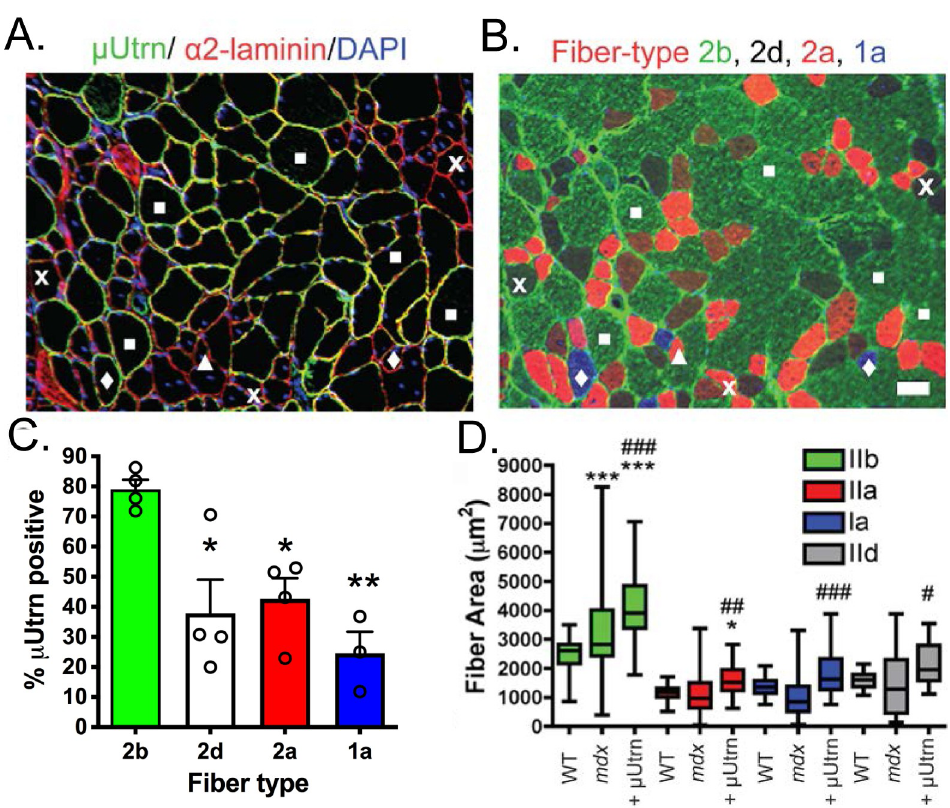
Fig 4. μ Utrn expression mitigates dystrophic pathology and demonstrates fiber-type preferences in gastrocnemius muscles. (A) Immunostaining for utrophin A indicating high level expression of (green), laminin A (red), and nuclei (blue). (B) Adjacent sections of μ Utrn treated mdx 4cv muscles with corresponding fiber typing. Symbols provide examples of 1a, 2a and 2d/x fibers expressing high levels of μ Utrn. The white squares, “x’s”, triangles, and diamonds indicate type 2b, 2d/x, 2a, 1a fibers respectively. Scale bar = 50 μ m. (C.) Quantification of the proportion of fiber types expressing μ Utrn (Mean +/- S.D.). (D.) Myofiber area as indicated by fiber type. Box and whiskers plots displaying median +/- 75% fiber area in wild-type, mdx 4cv and mdx 4cv treated skeletal muscles. μ Utrn expression leads to myofiber hypertrophy in all muscle fiber types. Bars show the mean +/- S.D., (N = 4). � P < 0.05 and �� P < 0.01 relative to wt # P < 0.05, ## P < 0.01, ### P < 0.001 relative to untreated mdx 4cv